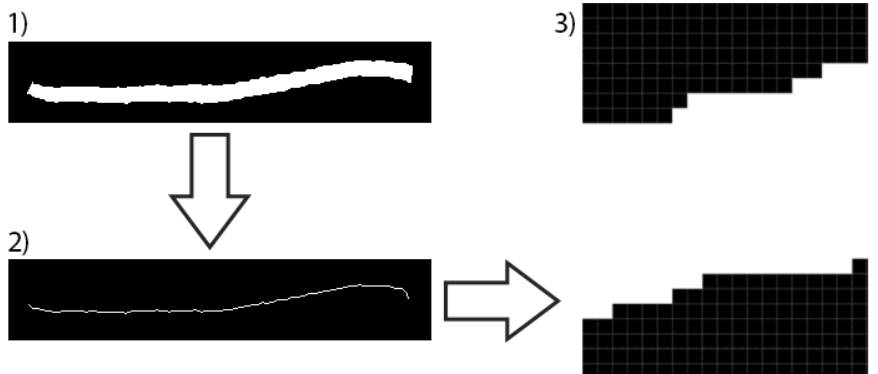
Figure 7. Proceeding to get the (1) area, (2) length and (3) thickness of a